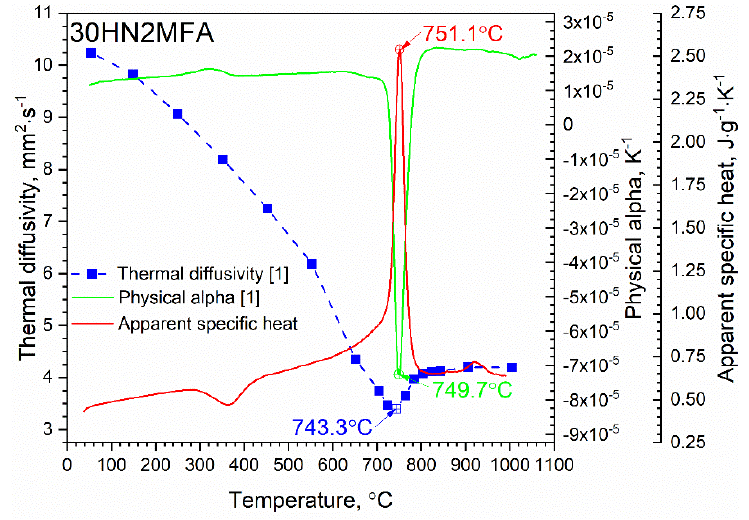
Figure 8. Thermal diffusivity, physical alpha, and apparent specific heat of 30HN2MFA barrel steel.